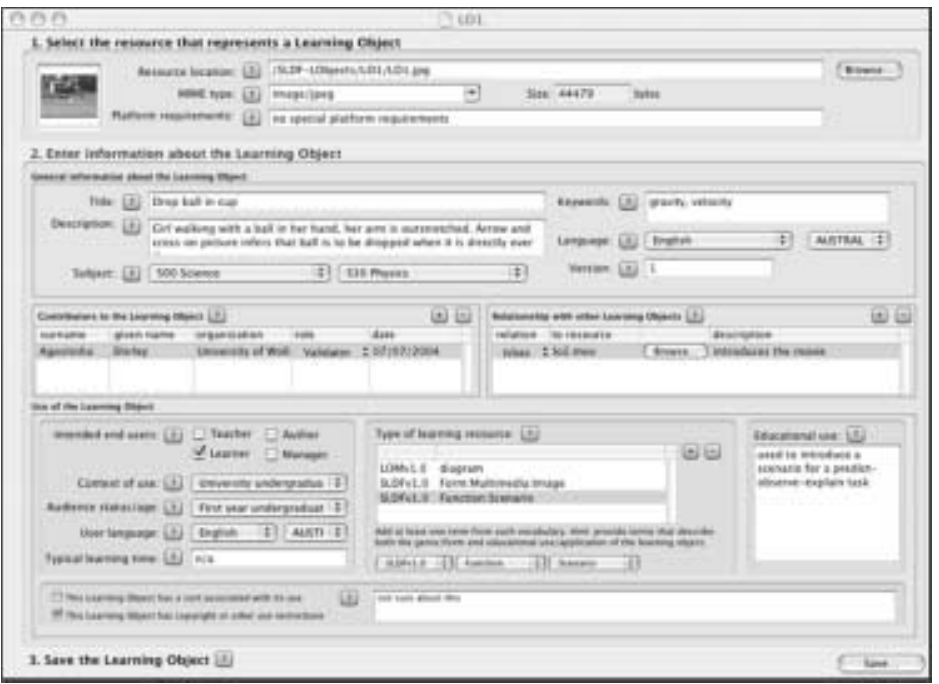
Figure 3. Creating a metadata record for the image of a girl with a